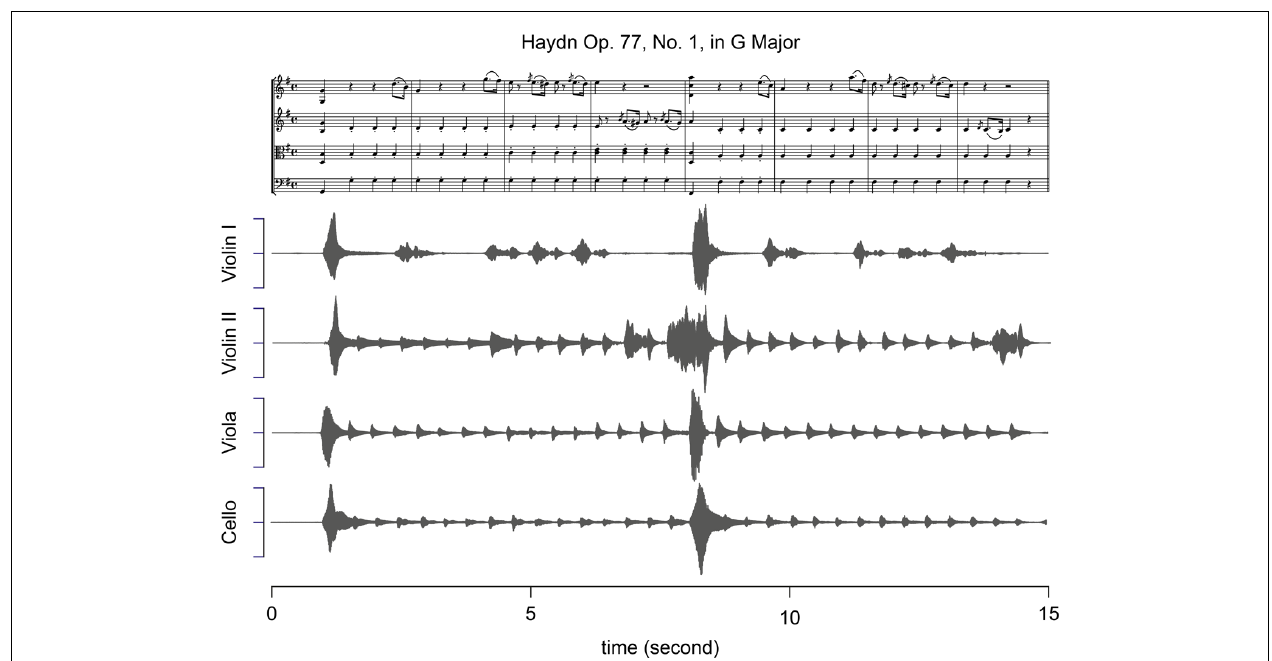
FIGURE 1 |The excerpt from the first movement of Haydn’s G Major string quartet, Op. 77 No. 1 played by the quartet and an example of audio data by each performer.